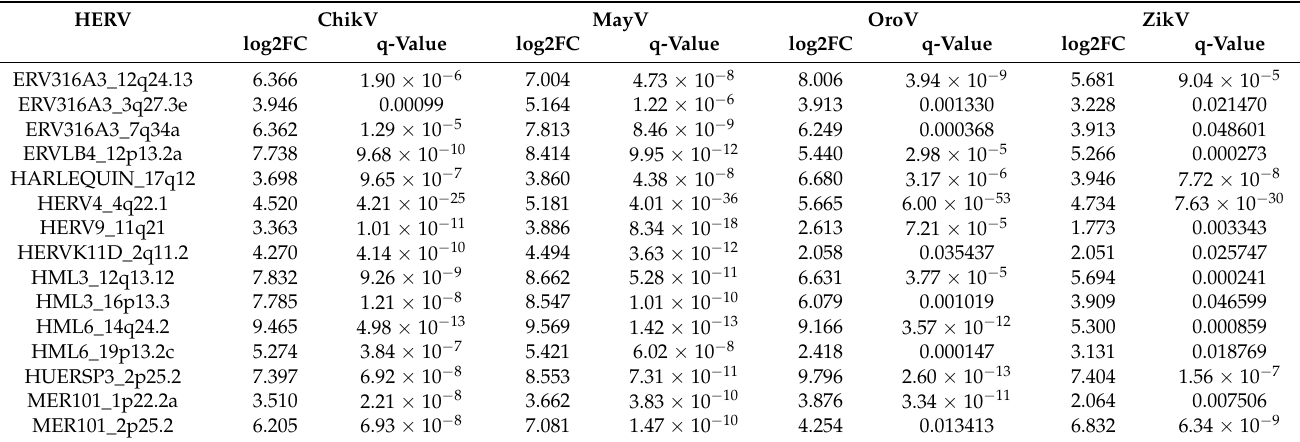
Table 1. Differentially expressed HERVs present in all viruses.